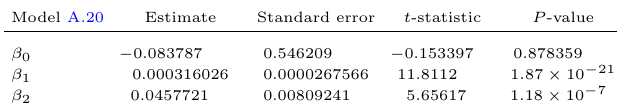
Table A.10. Regression results for model